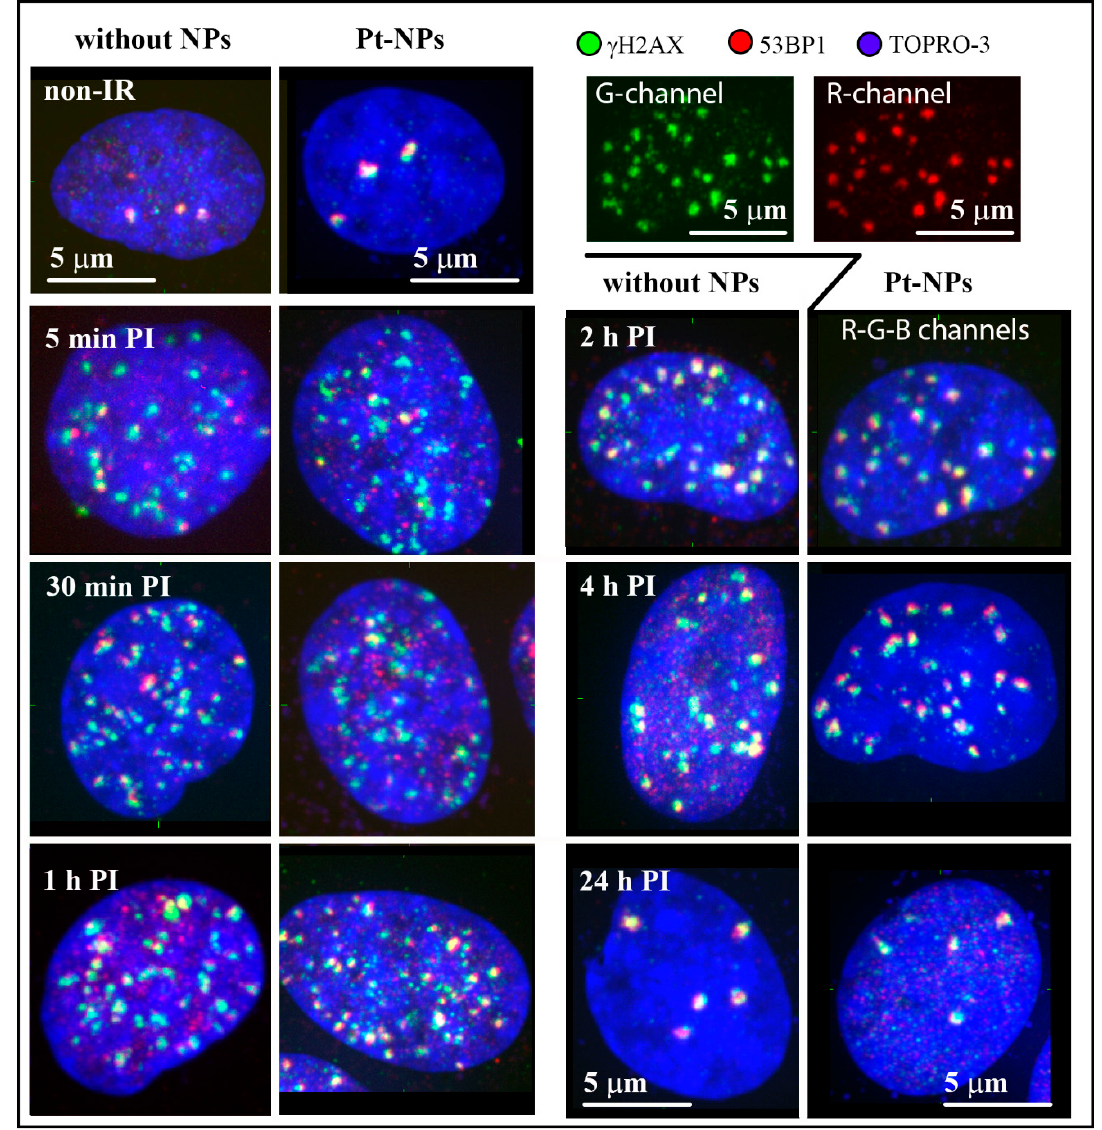
Figure 2. γ H2AX/53BP1 foci (DSB) formation and repair kinetics in U87 cells incubated or not incubated with 2.6 nm platinum nanoparticles (Pt-NPs; 0.5 mM for 6 h) and consequently irradiated with 4 Gy of γ -rays. Maximum images (see Figure 1) are displayed for representative nuclei of cells that were spatially (3D) fixed in the indicated periods of time PI. For the nucleus fixed at 2 h PI, γ H2AX foci (inserted G-channel panel) and 53BP1 foci (inserted R-channel panel) are also shown separately to demonstrate their mutual co-localization. γ H2AX (green), 53BP1 (red), and chromatin counterstained with TO-PRO-3 (artificially blue). None-IR figures correspond to non-irradiated cells.